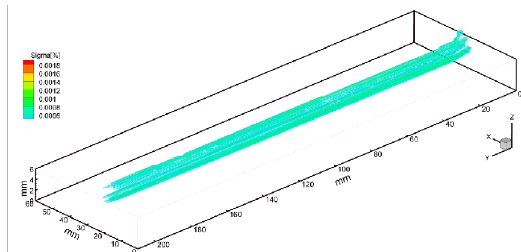
Figure 13. Predicted sigma phase evolution resulted after the finishing welding pass (heat input =1.2 kJ mm -1